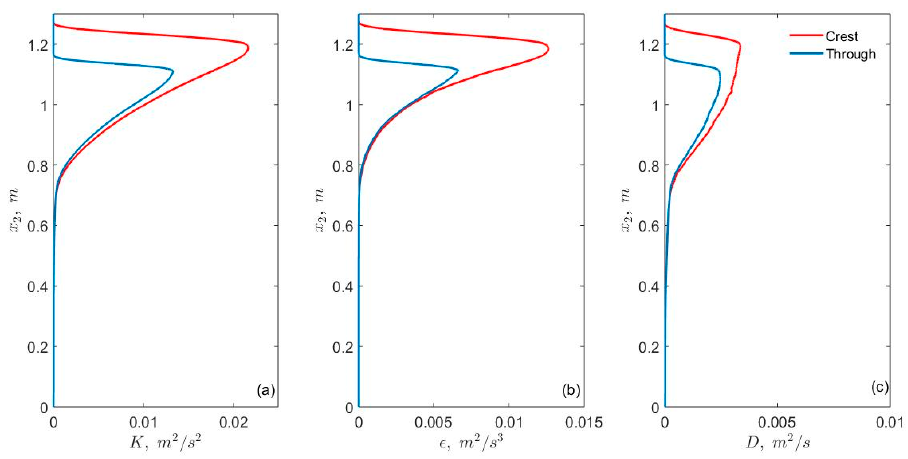
Figure 6. Vertical variation of turbulent kinetic energy (m 2 s − 2 ) ( a ), turbulence kinetic energy (TKE) dissipation rate (m 2 s − 3 ) (b) , and eddy diffusivity (m 2 s − 1 ) ( c ) underneath a crest ( x 1 = 1.56 m) and a trough ( x 1 = 2.34 m) of the wave.